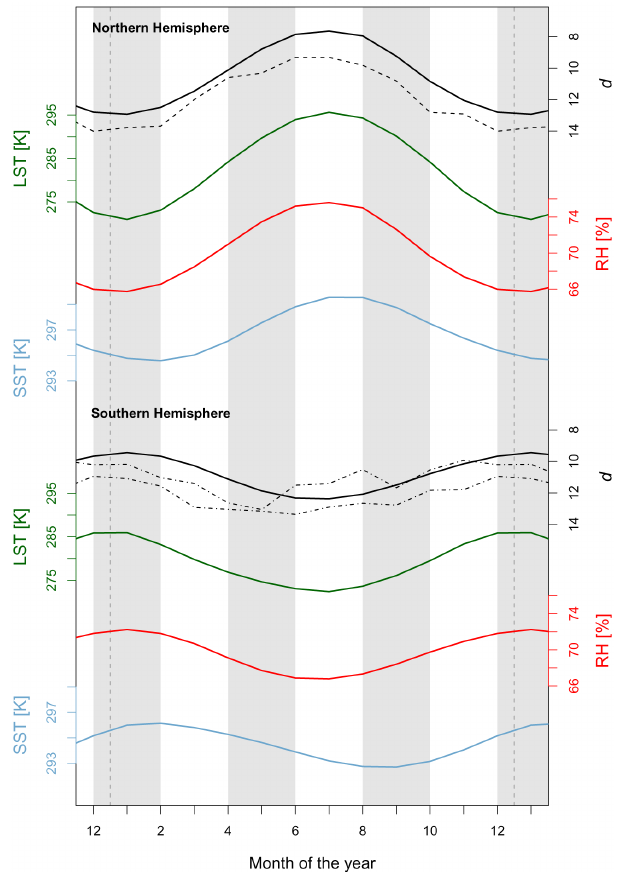
Fig. 4. Hemispheric mean seasonal cycle of predicted d in com- parison with other variables. The black lines show the averaged d of ocean evaporation as predicted by the regression model. Green lines show averages of land surface temperature (LST). Mean RH over the ocean and SST, both weighted with the surface latent heat flux, are shown by red and blue lines, respectively. Seasonally re- solved d from a shallow ice core from the NEEM site, Greenland, covering a 41yr period (Steen-Larsen et al., 2011) is shown as a dashed line. The dashed-dotted lines show the seasonal cycle from two cores from Law Dome, Antarctica, covering 12yr (Delmotte et al., 2000) shifted by 8‰.